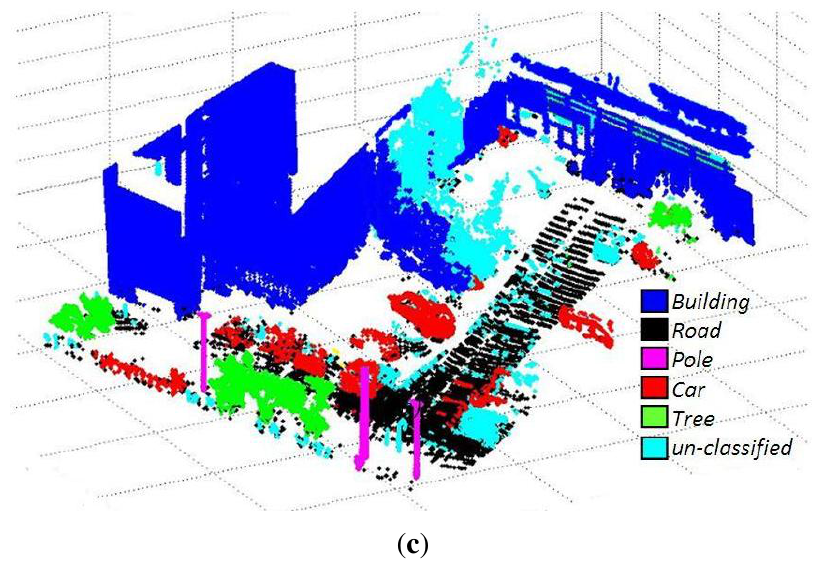
Table 2. Classification results of data set 1 with the new evaluation metrics.